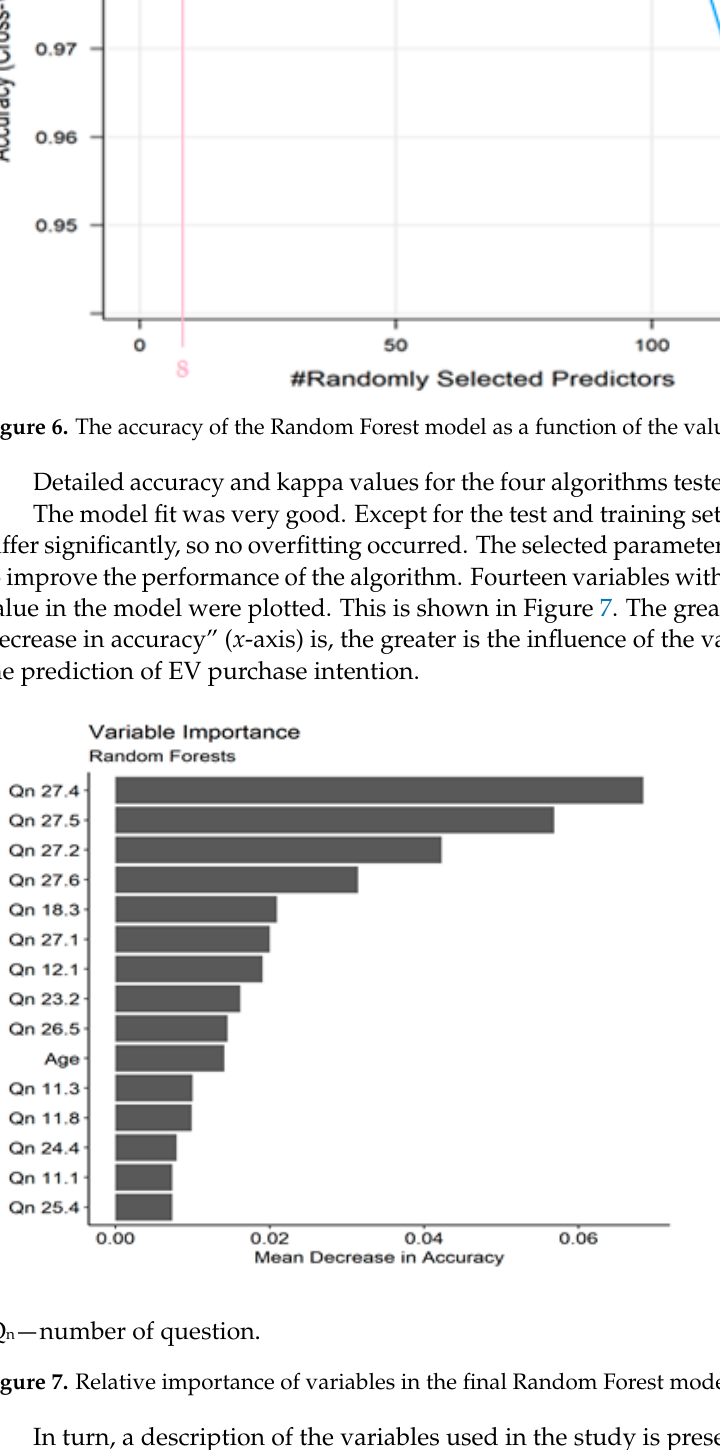
Figure 7. Relative importance of variables in the final Random Forest model. In turn, a description of the variables used in the study is presented in Table 6. Table 6. Description of the relative importance of the variables in the final Random Forest model with variable importance.